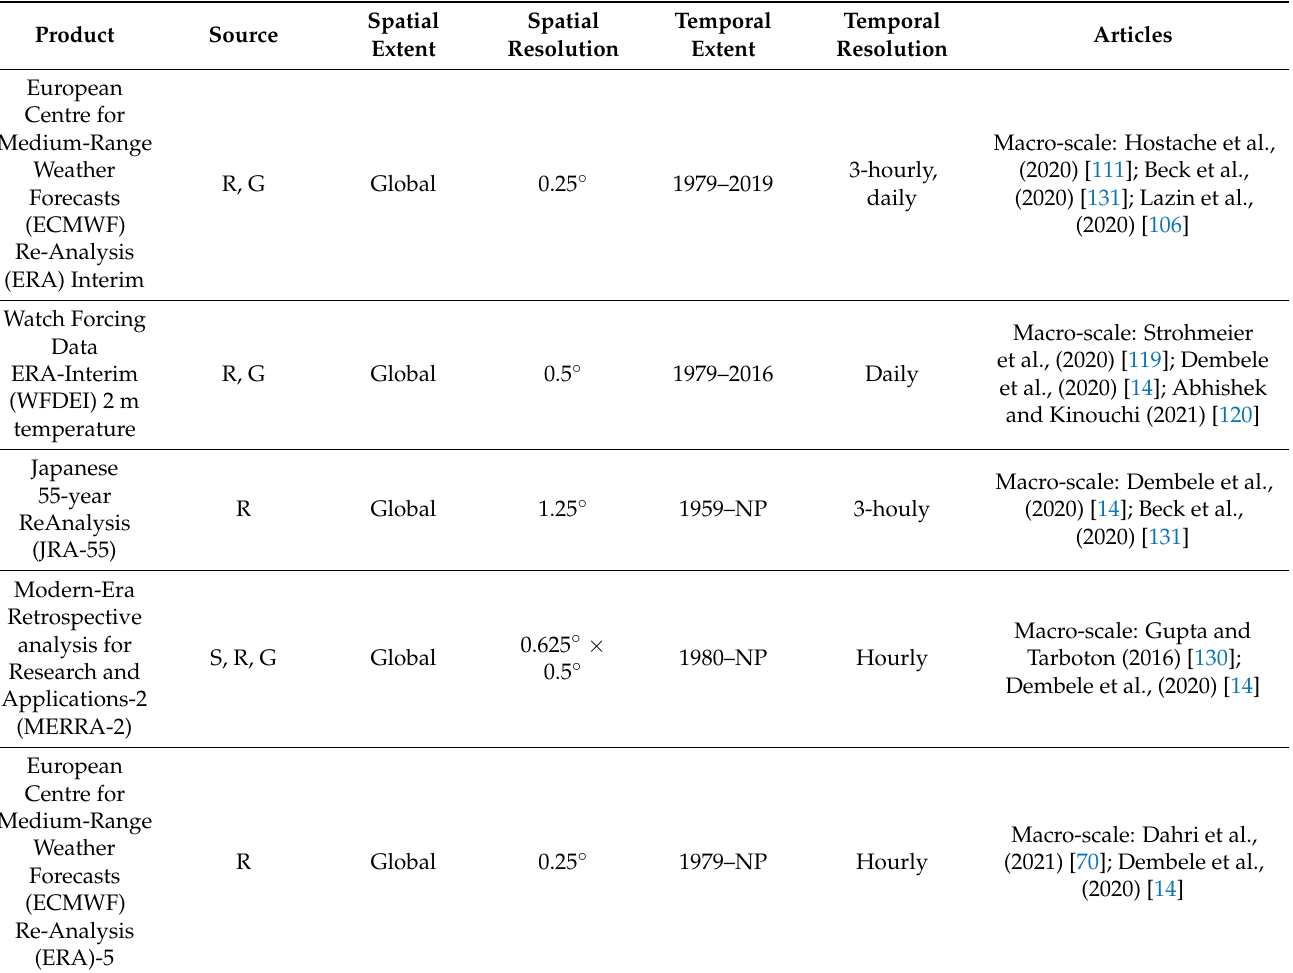
Table A9. Temperature products used in reviewed